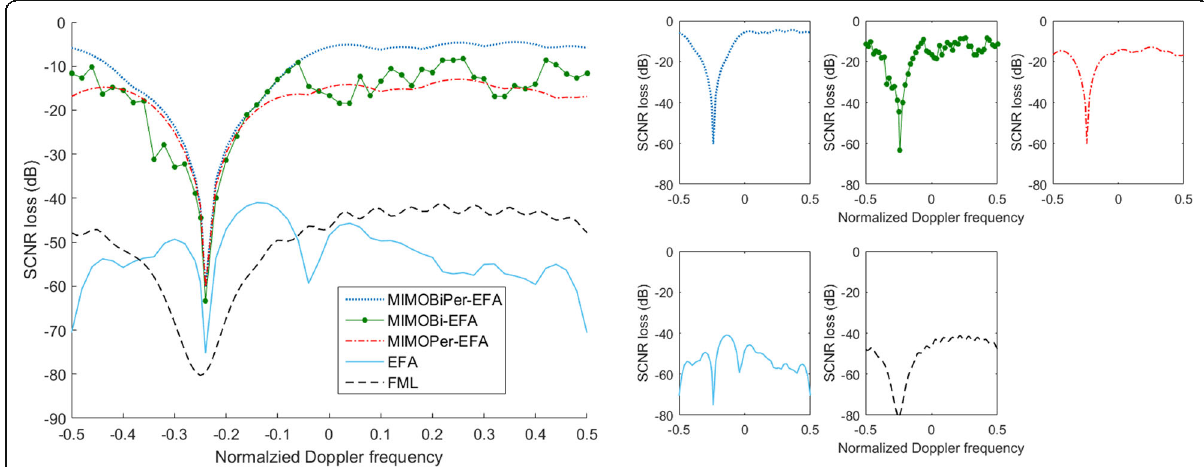
Fig. 7 SCNR loss curves with small training samples support under non-sidelooking scenario ( L =